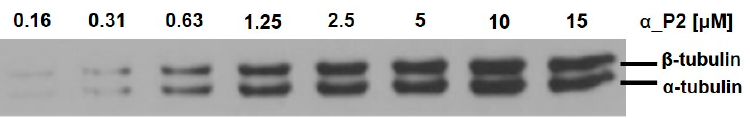
Figure 6. Western blot analysis to confirm the inhibition of microtubule polymerization using anti-His-antibody (rabbit monoclonal antibody, 1:1000 dilution in bovine serum albumin in Tris-buffered saline (TBST)). Reaction products were resolved on 12% SDS-PAGE, followed by Western blot analysis.